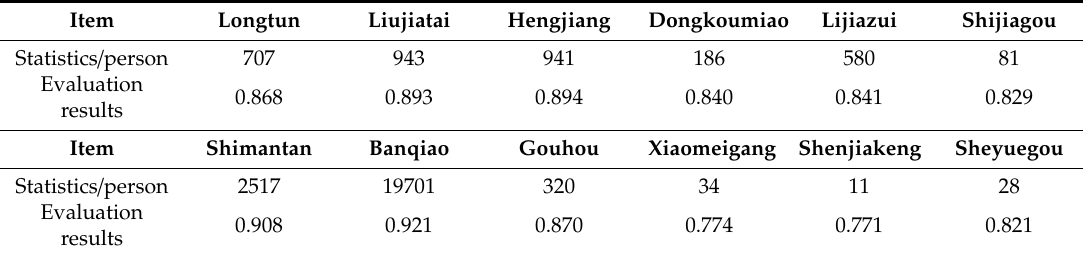
Table 5. Severity evaluation and statistics of loss of life of dam breach.